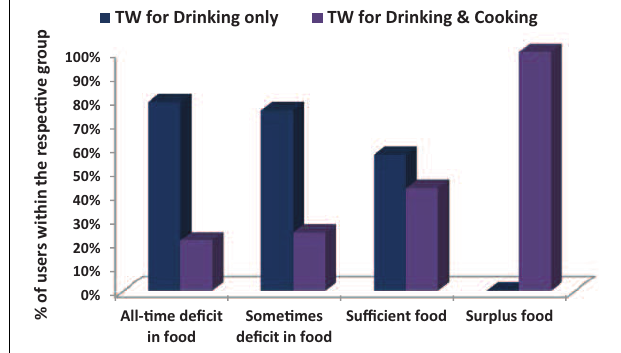
FIGURE 11 | Influence of household economic condition on water use